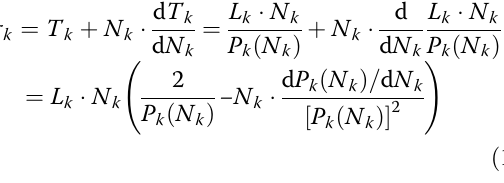
Table 1 Total delay of road network (107(veh·s))